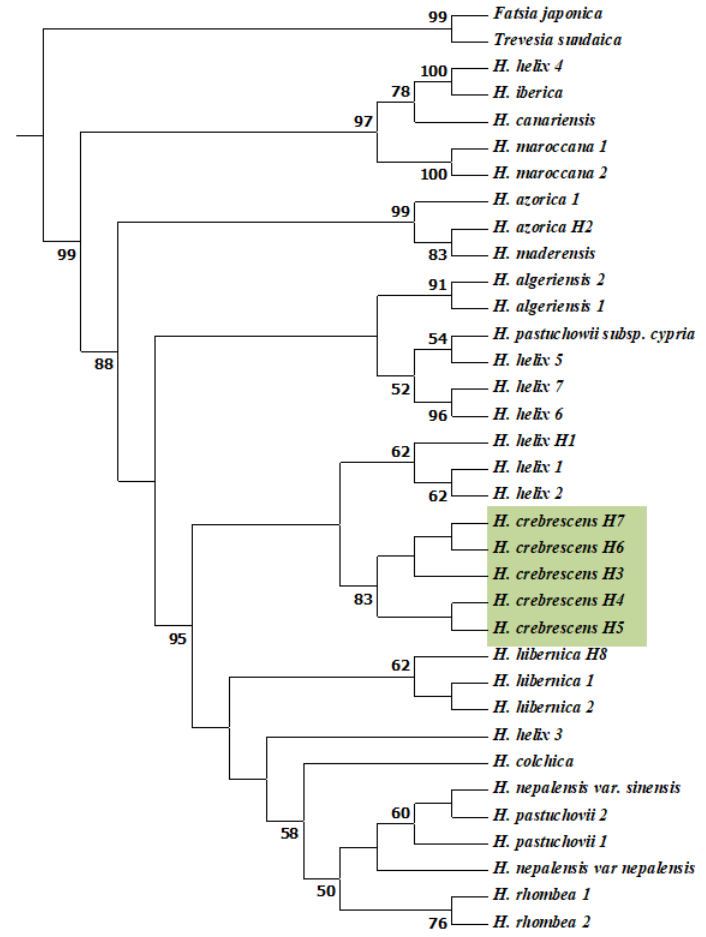
Figure 3 A consensus tree ofthe five concatenated cpDNA regions generated using the maximum likelihood method. Numbers above branches show the bootstrap values from 200 replications (bootstrap values less than 50% are not